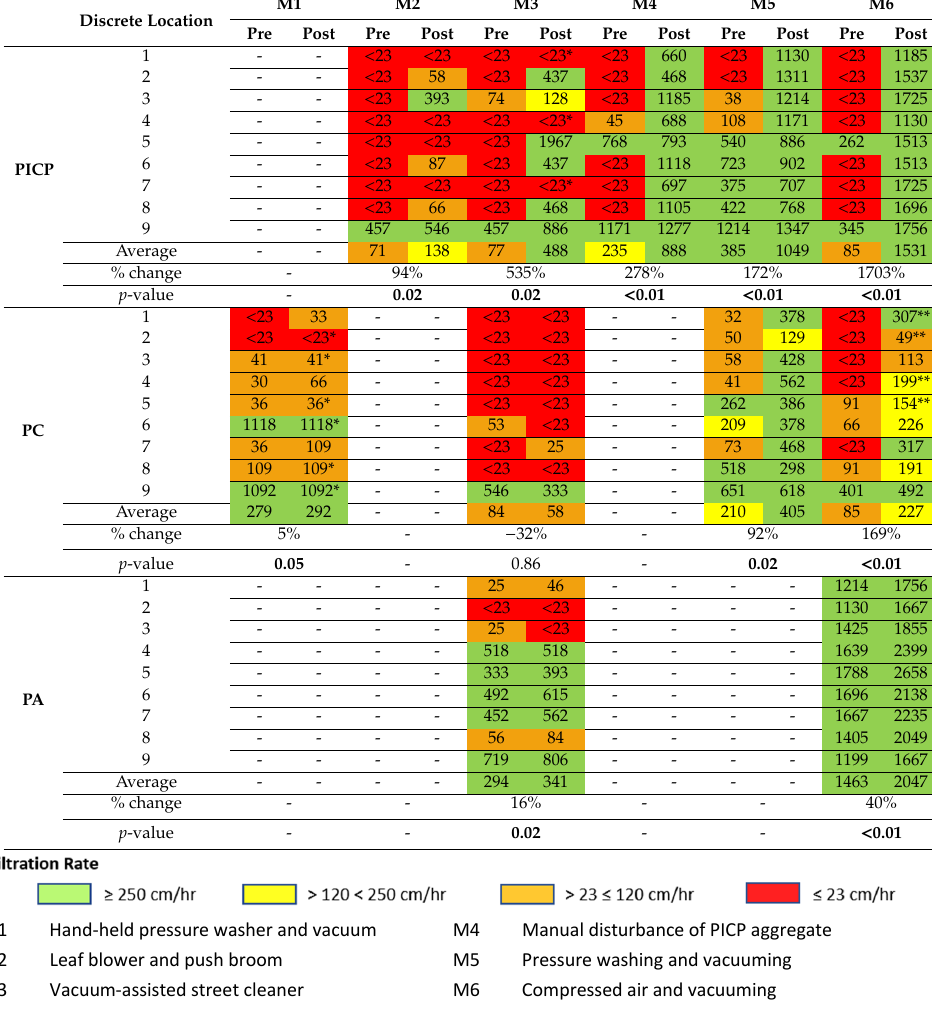
Table 1. Infiltration rates before and after each restorative maintenance practice as measured at the discrete locations and the results of average surface infiltration rate and percent change at the permeable interlocking pavers (PICP), pervious concrete (PC), and porous asphalt (PA) test plots (-, no tests done; * no treatment performed on discrete location; ** treatment duplicated on discrete location; values in bold indicate a significant increase in infiltration capacity at the 95% confidence level; a negative value indicates a decrease in infiltration capacity; cm/h, centimeters per